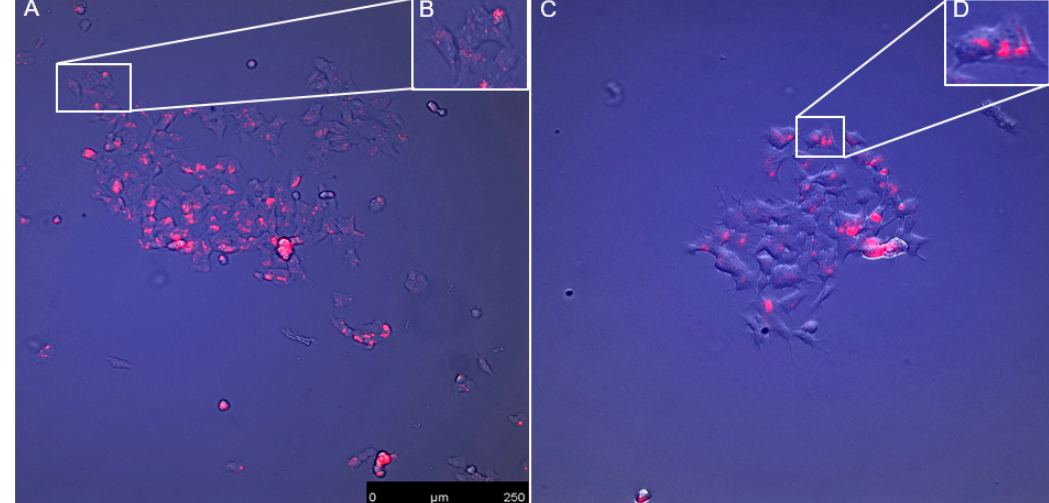
Figure 8. Distribution of the LysoTracker DND-99 probe in both control cells ( A ) and PABA-treated cells ( B ). ( C ) and ( D ) show small localisation of LysoTracker in the cells. Suggests that PABA has little to no effect on the cellular distribution of the probe. Images taken using the Leica DMI6000 fluorescent microscope, with the Leica LAS X software, at x40 (objective).